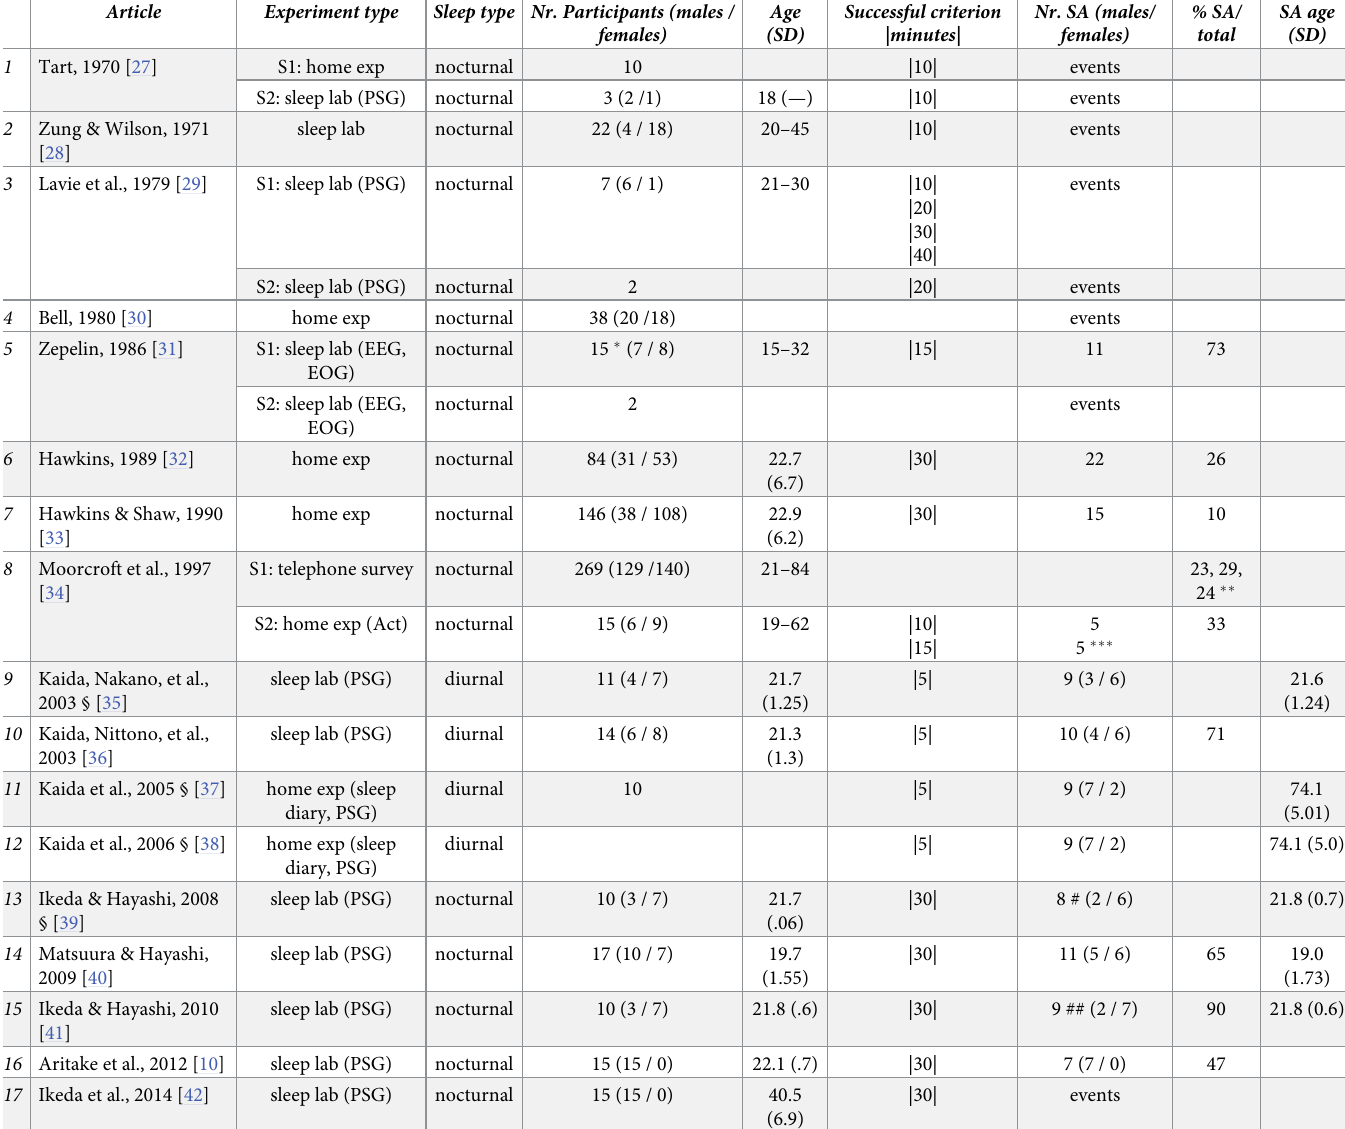
Table 2. Results of the literature review. “Experiment type”: location of the experiment and type of objective sleep validation (PSG = polysomnography, EEG = electroencephalography; EOG = electrooculography; Act = Actigraphy); in case of multiple studies within a paper, S1 indicates the first and S2 the second study. “Sleep type”: nocturnal or diurnal sleep. “Nr. Participants”: total experimental sample size. “Age (SD)”: age range or average for the whole participant group and corre- sponding standard deviations (SD) when available. “Successful criterion”: criterion used to define a successful self-awakener, usually a time window around the expected awakening time (absolute value in minutes). “Nr. SA”: number of self-awakeners explicitly reported in the study or whether the study investigated successful self-awaken- ing events. “% SA/total”: percentage of self-awakeners on the study sample size either reported in the manuscript or calculated based on the available data. “SA age (SD)”: age of self-awakeners and its standard deviation. Additional notes, symbols, and abbreviations: � 15 participants were recruited but only 12 underwent EEG. �� depending on the questionnaire question and concerning the ability to wake-up with or without an alarm; ��� five participants follow within the second criterion and are considered “moderately successful”; § = studies designed to select only self-awakeners; # = 9 self-awakeners were identified but data of one were lost, leaving 8 participants; ## = PSG failed for one participant, leaving 8 participants (6 F; mean age = 21.8 ± .6